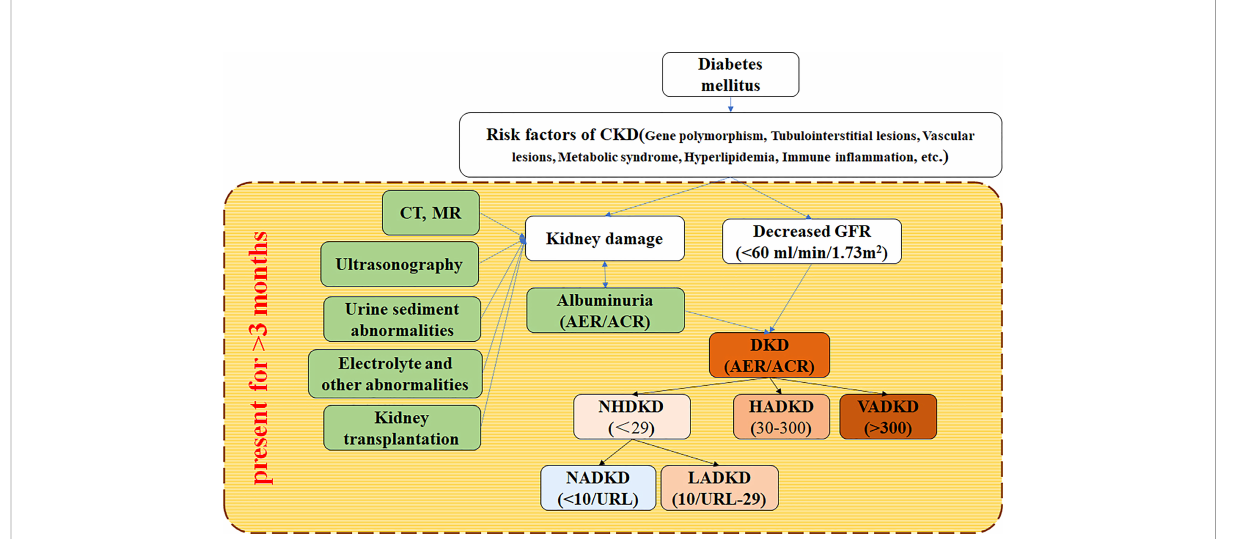
FIGURE 1 Flow for diagnosing NADKD according to KDIGO 2012 clinical practice guideline KDIGO (2012) de fi nes CKD as abnormalities of kidney structure or function more than 3 months, which affects health. CKD is diagnosed according to markers of kidney injury and decreased GFR. DKD is a kind of CKD. CKD, chronic kidney disease; DKD, diabetic kidney disease; NADKD, normoalbuminuric DKD; NHADKD, non-high albuminuria DKD; LADKD, low albuminuric DKD; HADKD, high albuminuric DKD; VHDKD, very-high albuminuric DKD; CT, computerized tomography; MR, magnetic resonance imaging; ACR, urine albumin-creatinine ratio(unit: mg/g creatinine); AER, albumin excretion rate (unit: mg/24h); URL, upper reference